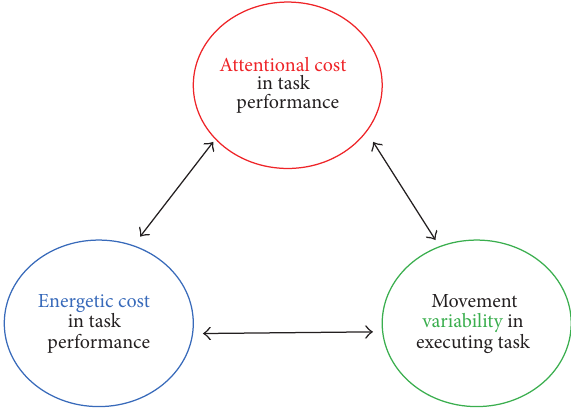
Figure 5: Interrelationship of movement variability with attention and energy expenditure while performing